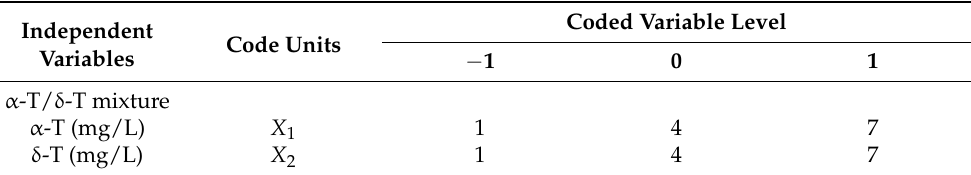
Table 9. Experimental values and coded levels of the independent variables used in the 3 × 3 factorial